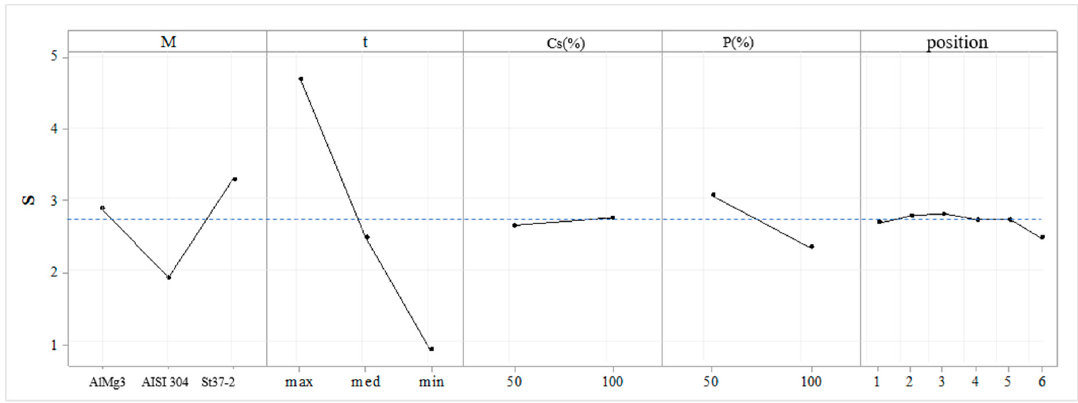
Figure 11. Main effects plot for kerf section.